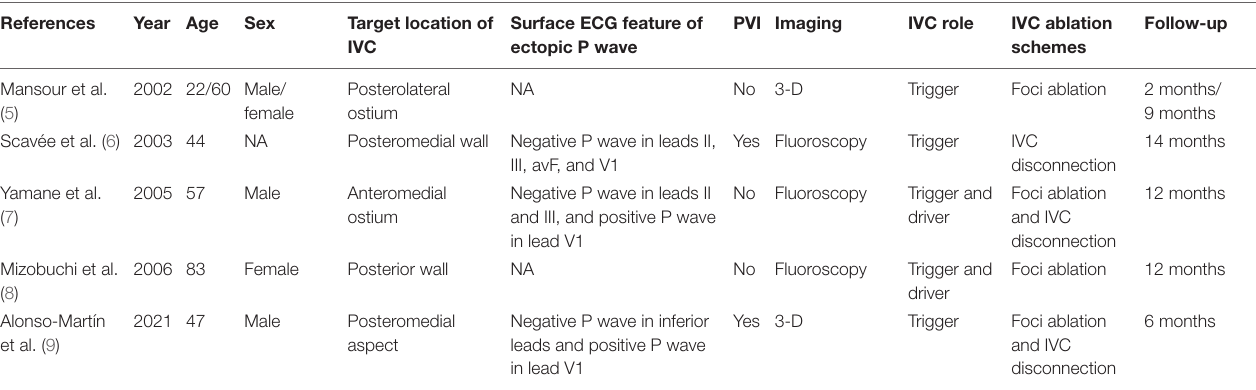
TABLE 2 | Baseline characteristics of previous case